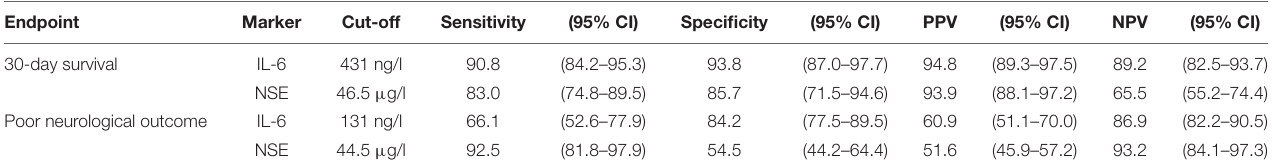
FIGURE 3 | ROC curves for NSE and IL-6 for 30-day survival (A) and poor neurological outcome (B) . For both p was < 0.001. TABLE 3 | Sensitivity, specificity and predictive values for identified cut-off